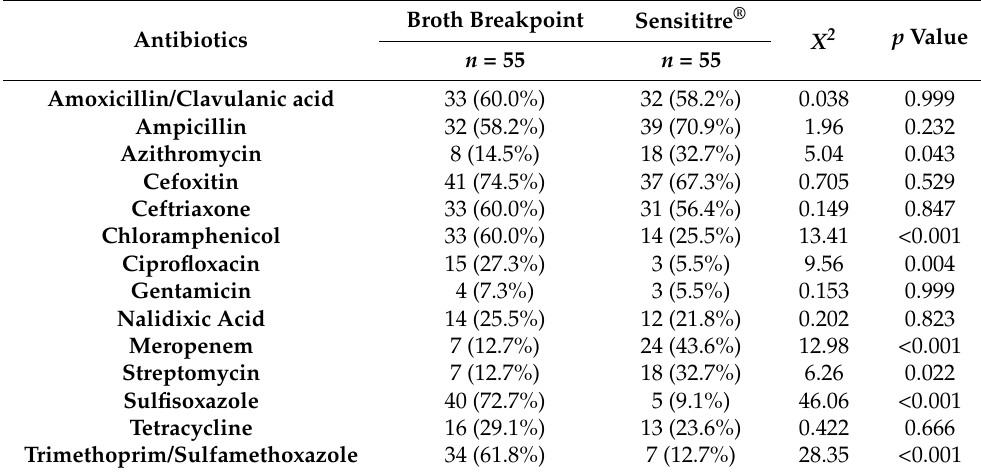
Table 3. Effects of antimicrobial susceptibility testing methodology on resistance ratios of poultry Salmonella collected via direct plating in trial one (equal sample size).